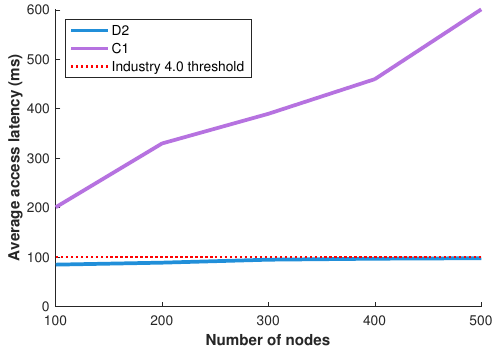
Figure 9. Scalability performance in